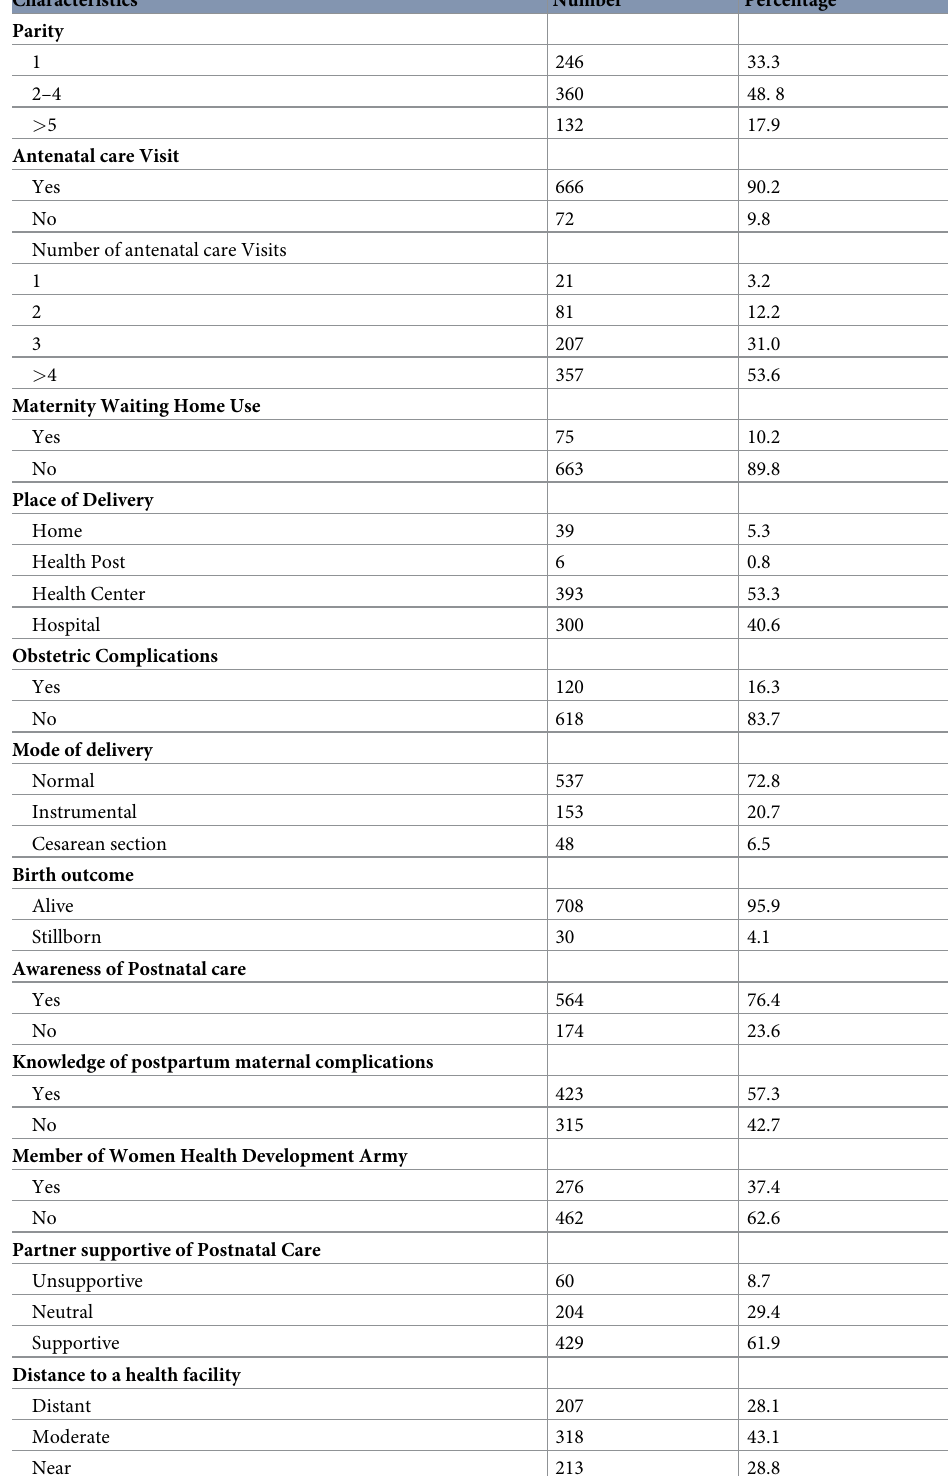
Table 2. Obstetric and behavioral characteristics of participants.